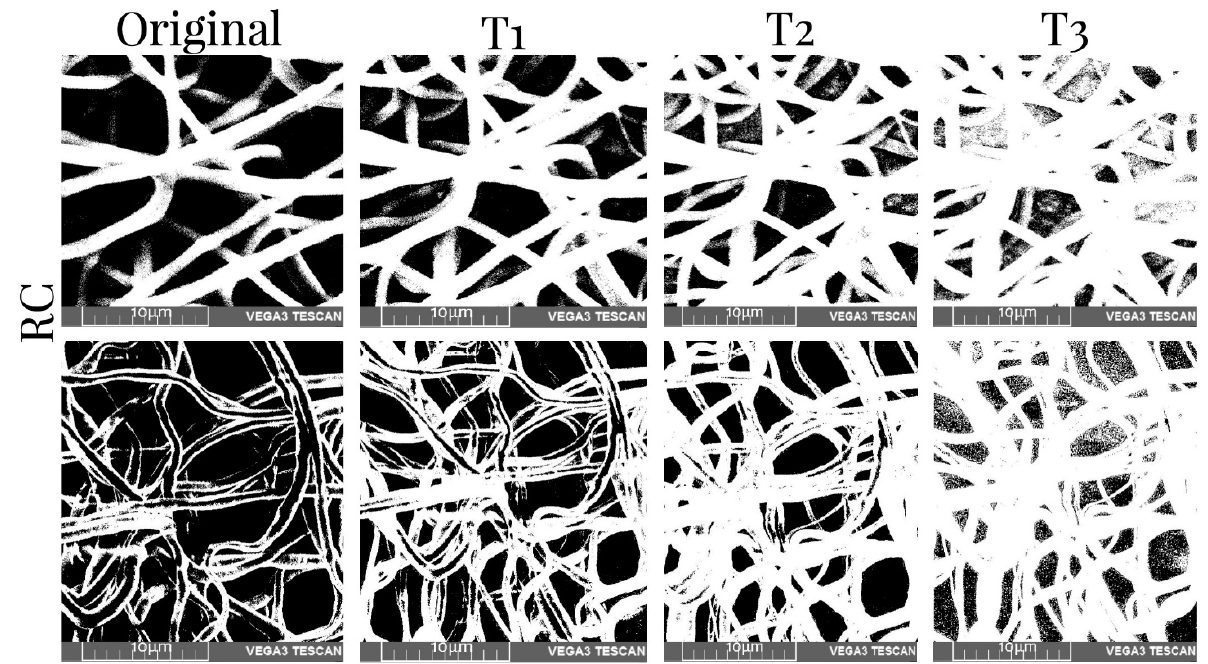
Figure 6. SEM images of the obtained RC45 scaffolds and binary images with three thresholds before (top row) and after mechanical tests (bottom row). T1–T3: threshold 1–3.